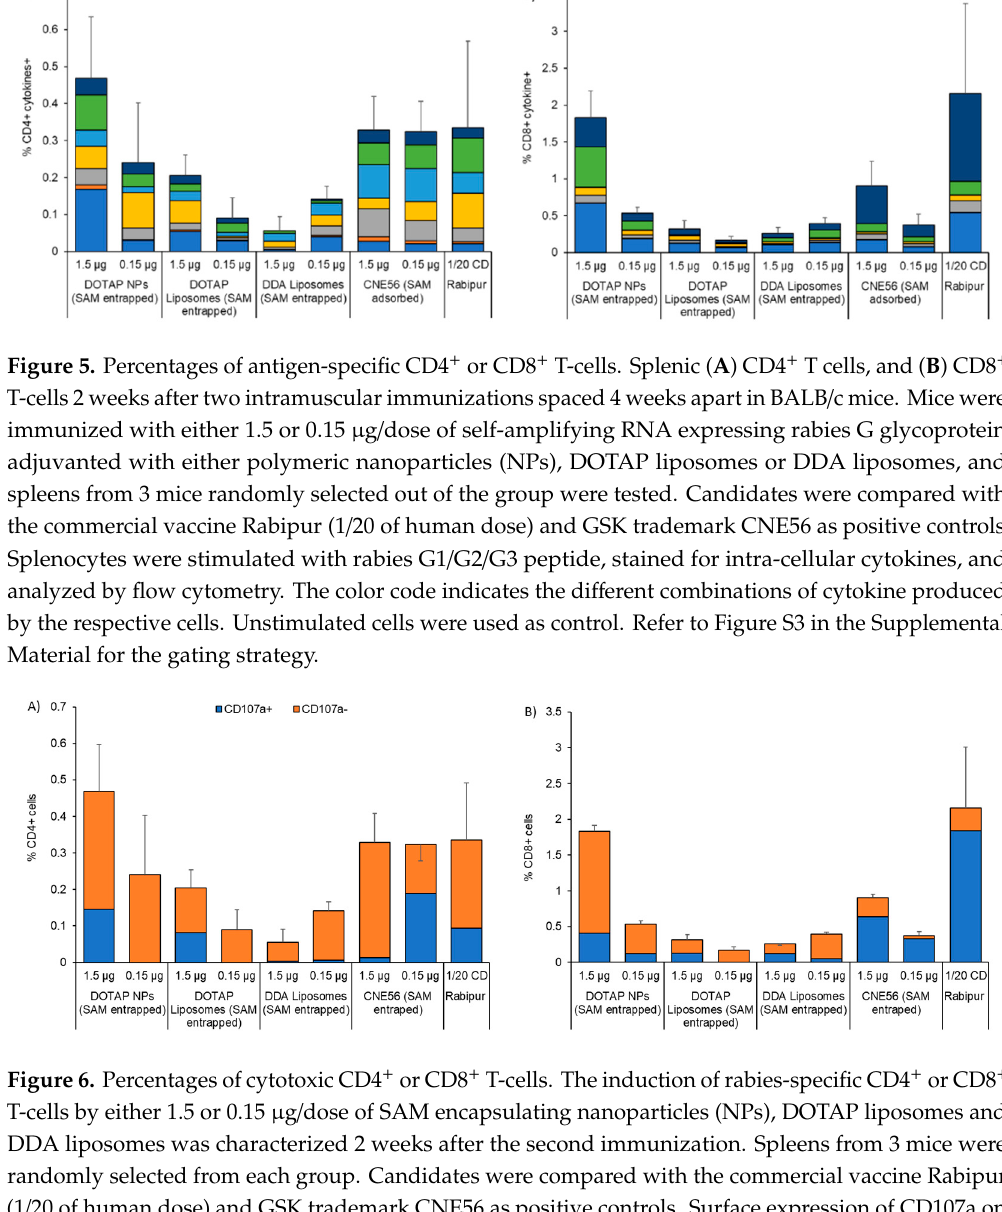
Figure 6. Percentages of cytotoxic CD4 + or CD8 + T-cells. The induction of rabies-specific CD4 + or CD8 + T-cells by either 1.5 or 0.15 µg/dose of SAM encapsulating nanoparticles (NPs), DOTAP liposomes and DDA liposomes was characterized 2 weeks after the second immunization. Spleens from 3 mice were randomly selected from each group. Candidates were compared with the commercial vaccine Rabipur (1/20 of human dose) and GSK trademark CNE56 as positive controls. Surface expression of CD107a on splenocytes stimulated in vitro with rabies G1/G2/G3 peptide was assessed by flow cytometry. Data show the frequency of cytokine-secreting ( A ) CD4 + or ( B ) CD8 + T-cells that express (blue bars) or do not express (orange bars) CD107a. Unstimulated cells were used as control. Refer to Figure S3 in the Supplemental Material for the gating strategy.